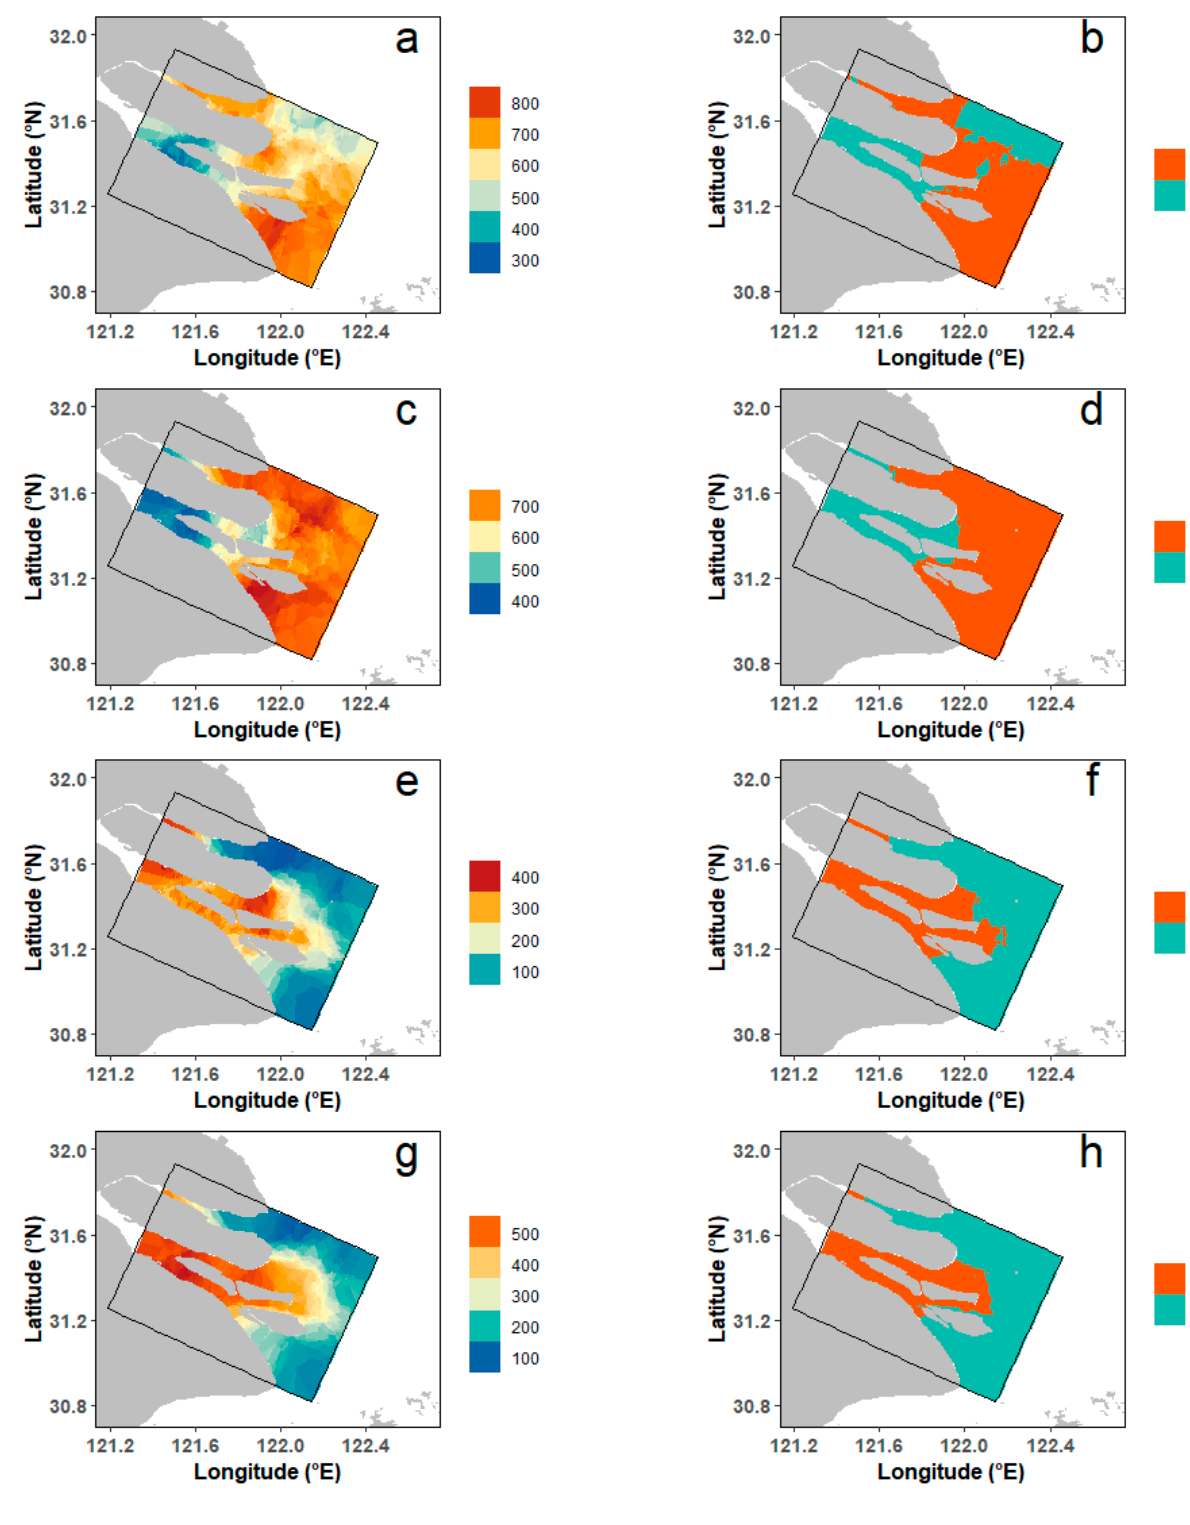
Figure 5. Suitable habitat areas of the four larval fish species (The legends of ( a , c , e , g ) represent the projected habitat suitability values). The legends of ( b , d , f , h ) represent presence or absence in this area. (( a , b ) C. mystus ; ( c , d ) E. japonicus ; ( e , f ) P. sinensis ; ( g , h ) H. bleekeri ).